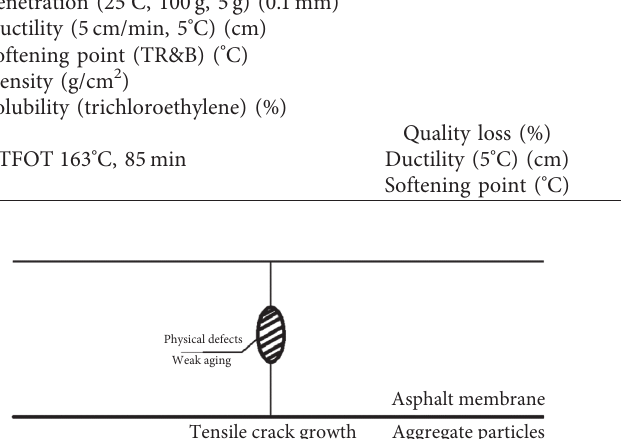
Figure 1: The weak state of the asphalt-aggregate interface.